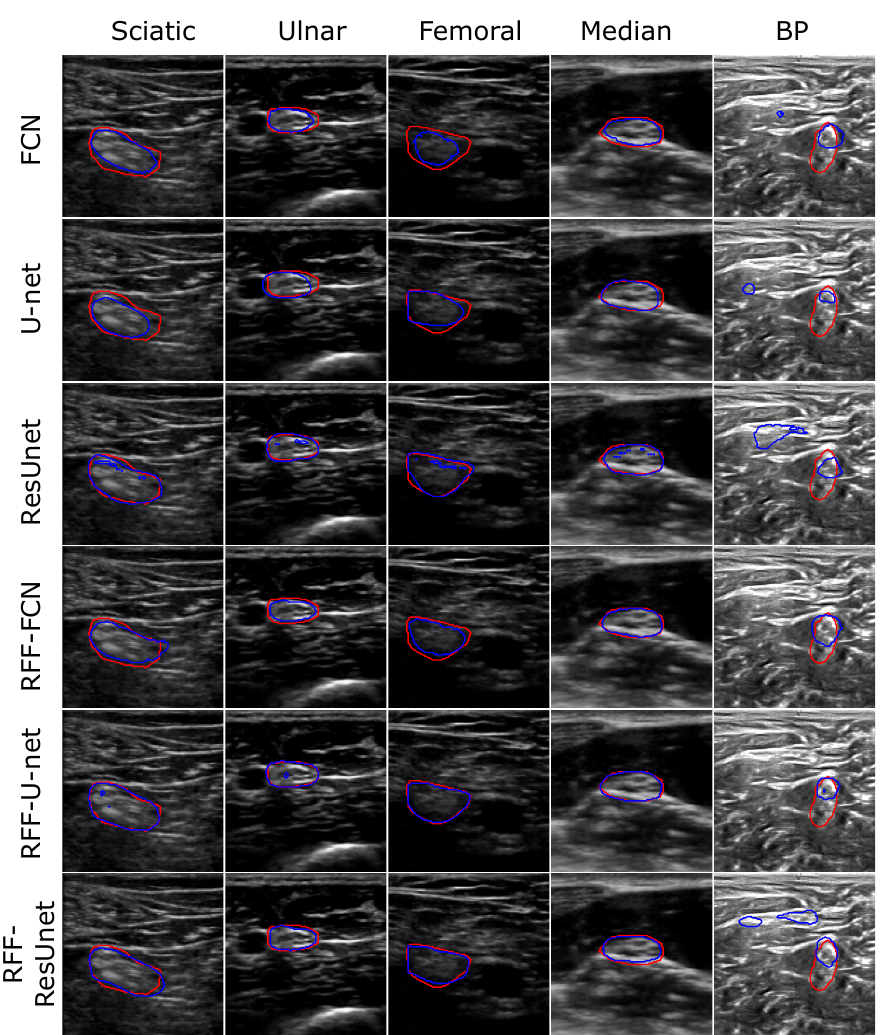
Figure 5. Visual inspection results for nerve structure segmentation (illustrative examples are shown). Red contour: target segmentation. Blue contour: predicted segmentation. The sciatic, ulnar, femoral, and median nerves are shown for the Nerve-UTP dataset. The brachial plexus (BP) of the NSD dataset is also presented. FCN [12], U-net [14,41], and ResUnet [16] algorithms were tested. Moreover, their RFF-based improvements (our proposal) are displayed, fixing the ˘ Q factor value as 128, 64, and 8 for RFF-FCN, RFF-Unet, and RFF-ResUnet on Nerve-UTP, and 128, 8, and 8 on